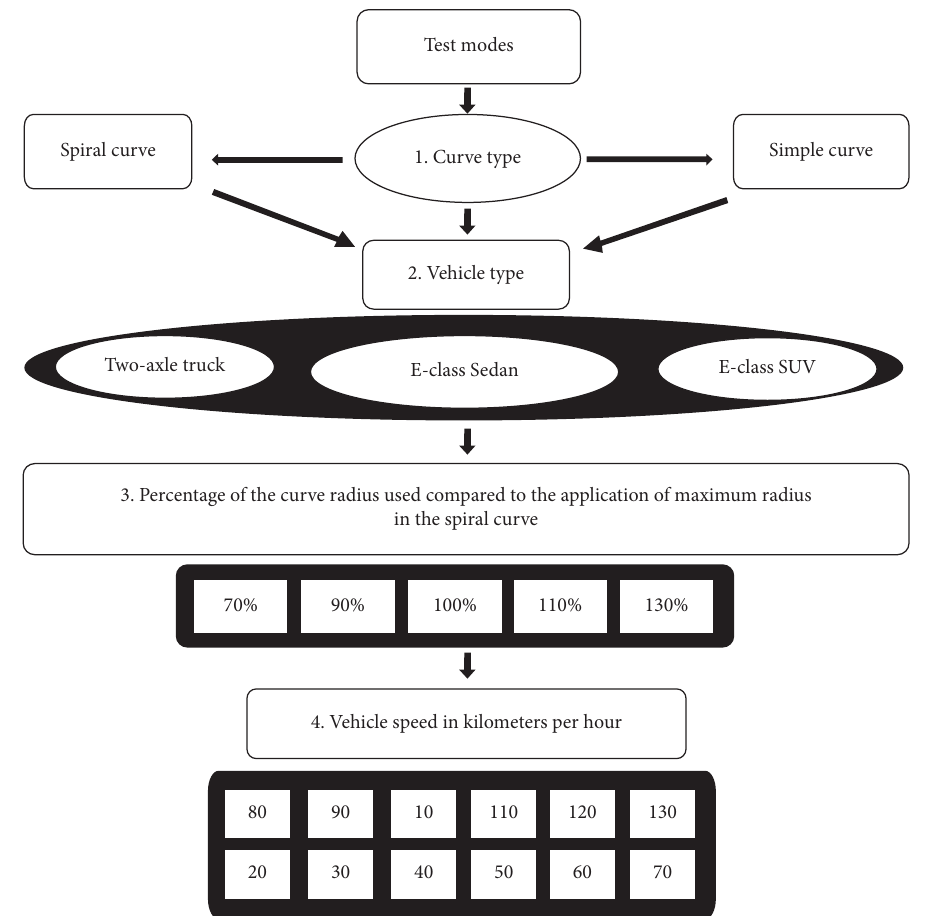
Figure 11: Flowchart of the tests presented in the research.